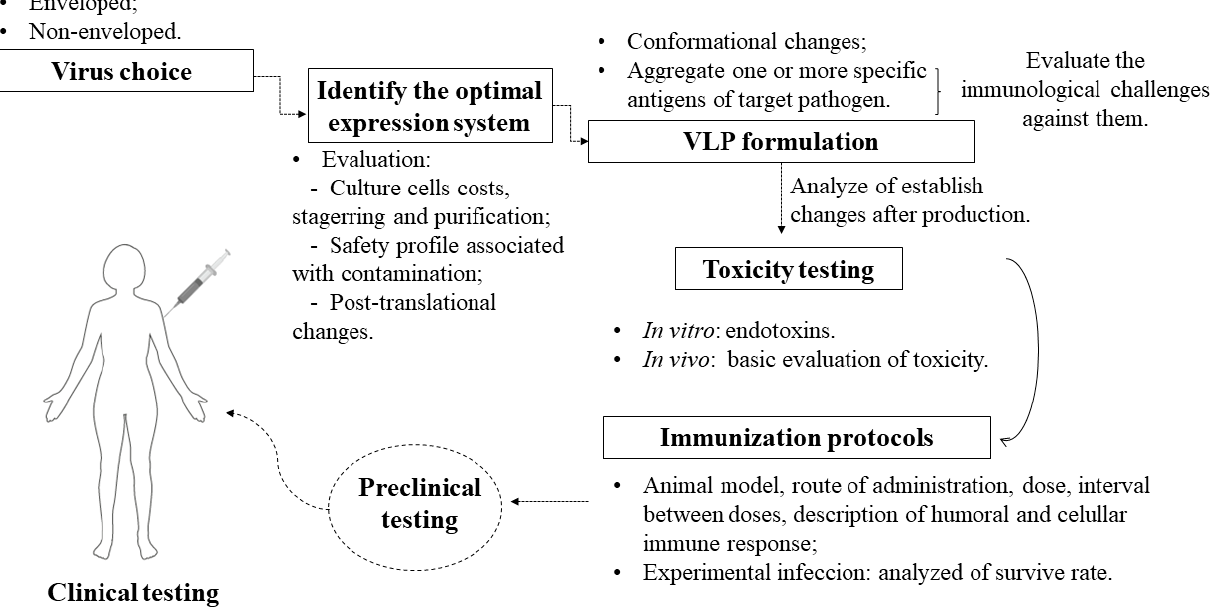
Figure 2. Representation of a rational scheme for the development of new vaccines based on virus-like particles (VLPs).